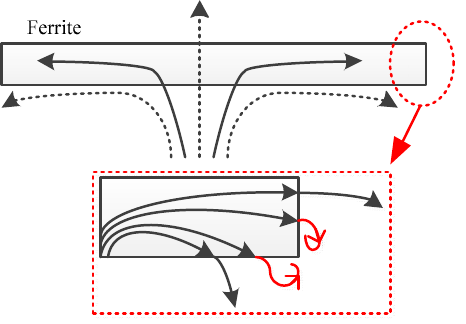
Figure 4. Magnetic field lines of shield of aluminum.